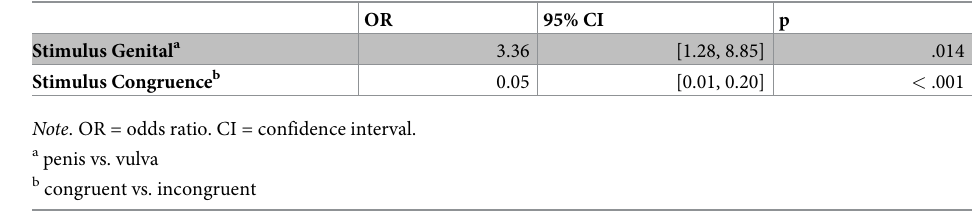
female. The mixed logistic regression analysis revealed significant effects of stimulus congru- ence and stimulus genital (see Table 2).